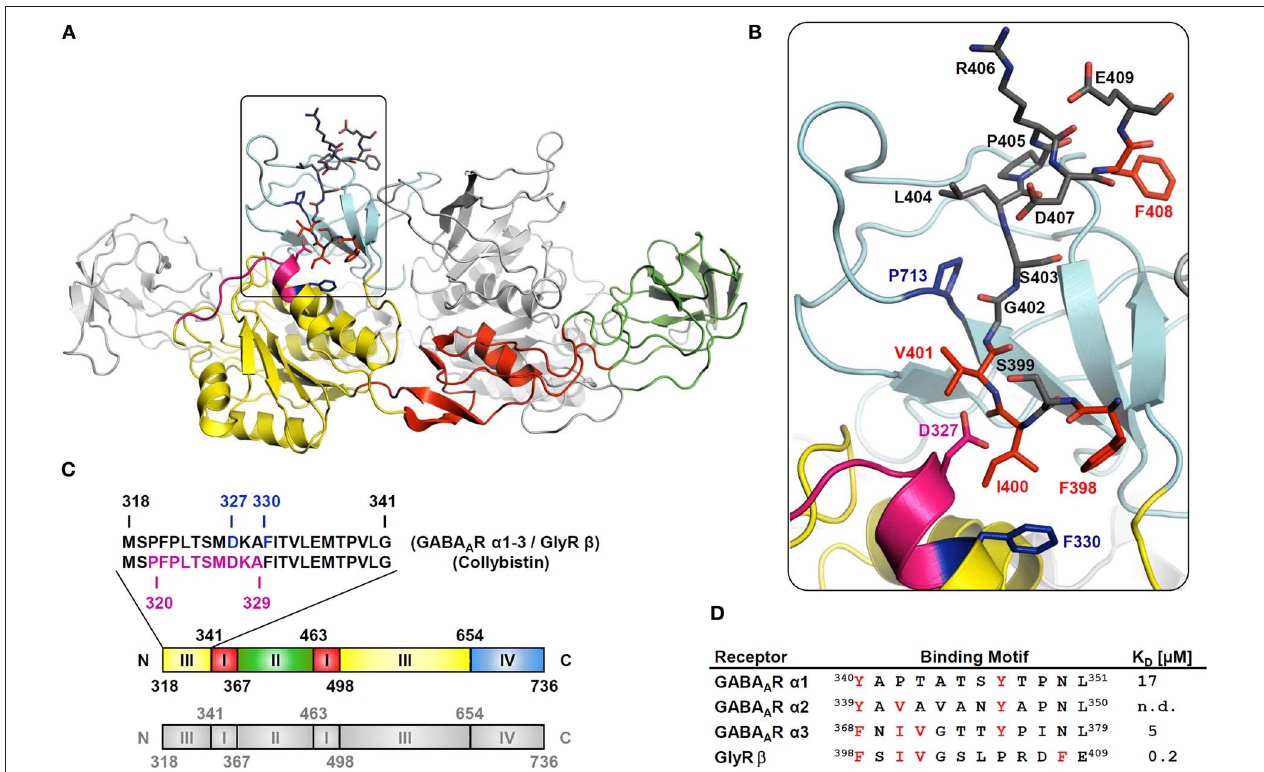
FIGURE 3 | Structural determinants of gephyrin, interacting with GABA A Rs, GlyRs, and collybistin. (A) Crystal structure of the gephyrin E domain (GephE) complexed with GlyR β , modified for comparison with GABA A R α subunits and collybistin. The ribbon diagram of GephE is colored to highlight its subdomain architecture. The GephE-domain is complemented by a second monomer shown in grey, representing the dimer that usually forms in vitro . Identified binding sites for collybistin on gephyrin are shown in magenta and overlapping binding sites for GlyR β and GABA A R α subunits are shown in light blue. The GlyR β peptide as well as crucial interacting amino acids in GephE (D327, F330, P713) are shown in stick representation. (B) The major contributing residues to the interaction are